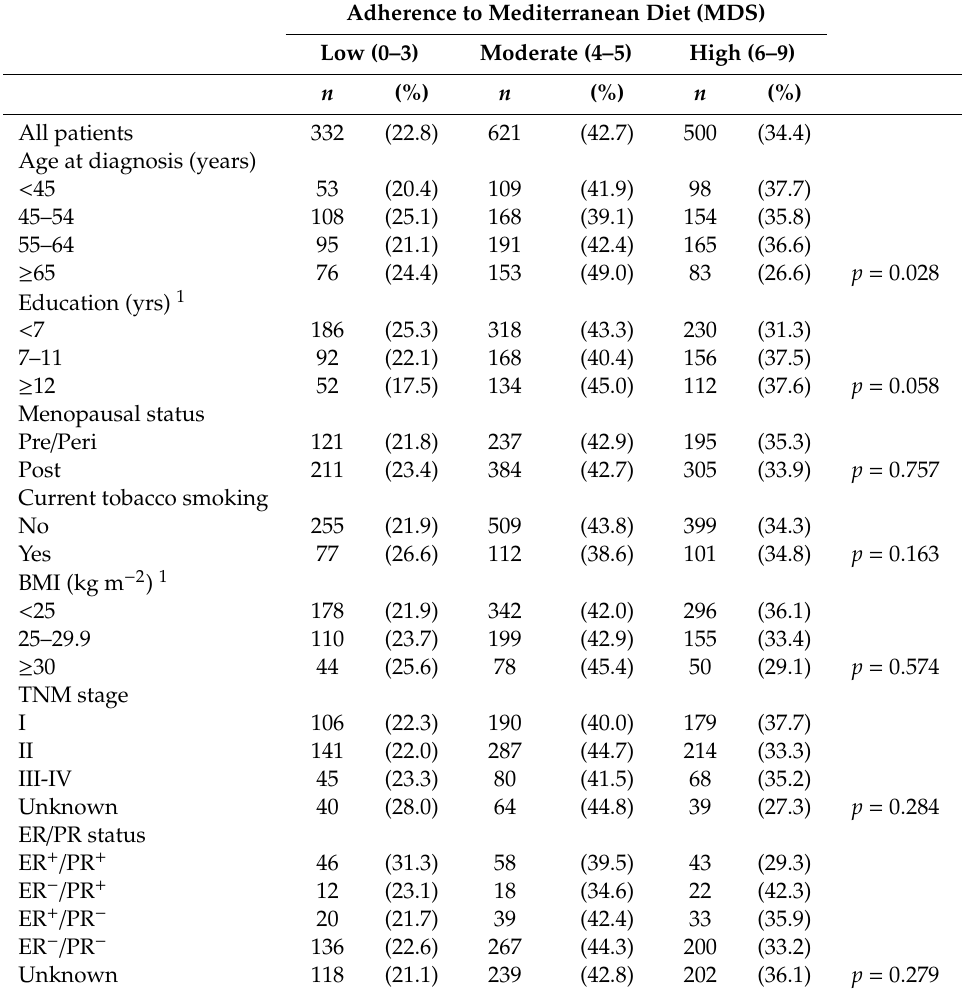
Table 1. Distribution of 1453 women diagnosed with breast cancer, according to baseline socio-demographic and clinical characteristics and Mediterranean Diet Score